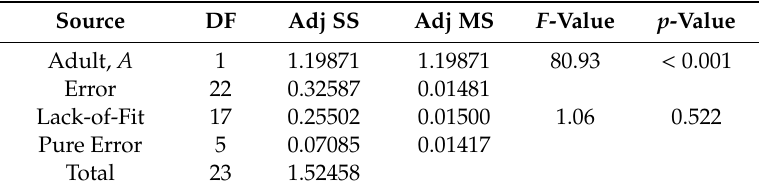
Figure 6. Relationships between adult density and ( a ) L 2 density, and ( b ) the ratio between L 2 density and adult density in 2008 and 2014. Lines: Equation (5). Treatments: 0 is untreated, 1 is Btk or tebuzenozide, 2 is pheromone, 3 is Btk and pheromone. Table 5. General linear model (Equation (5)) of the e ff ects of emerging adult density ( A ), Year ( Y ) and pheromone treatment ( T ) on L 2 density. Reduced model. Source